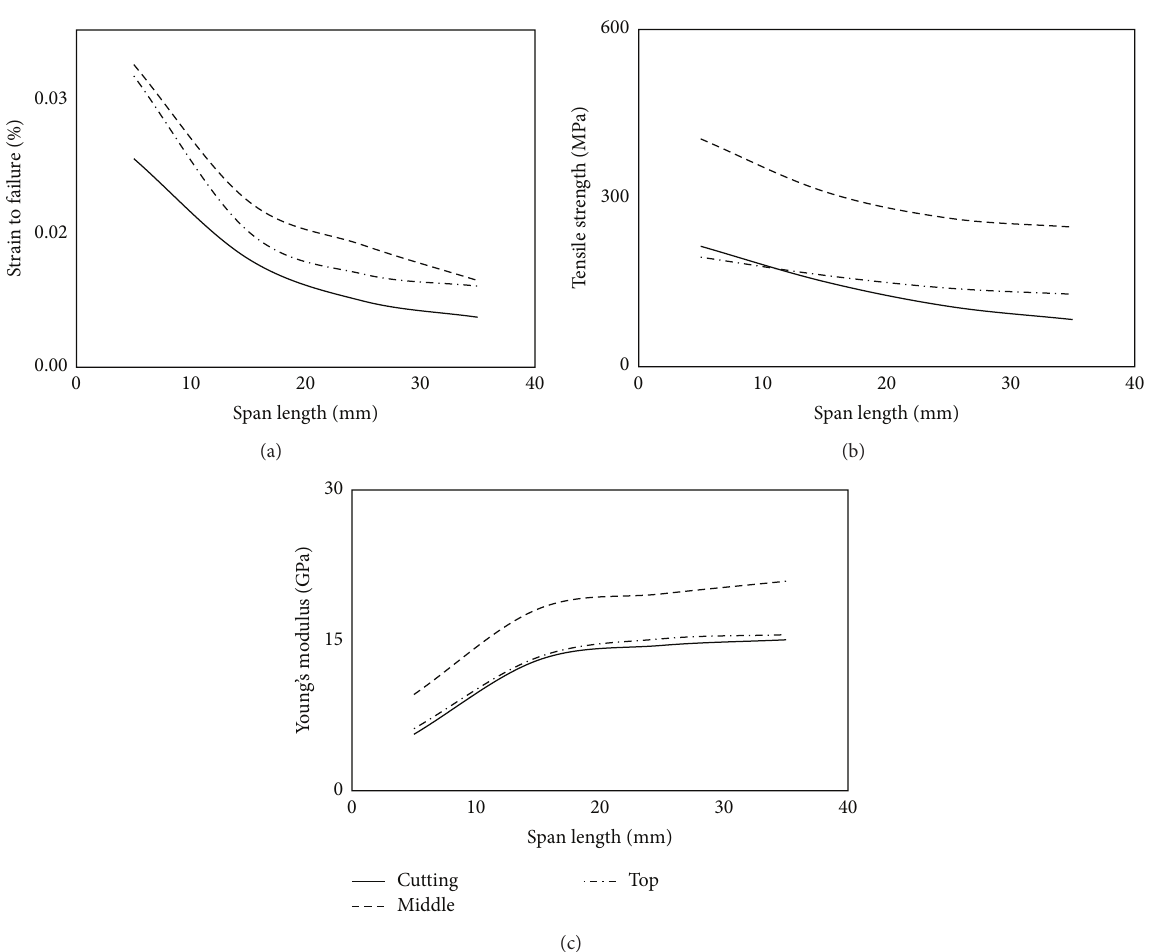
Figure 3: (a) Strain to failure, (b) tensile strength, and (c) Young’s modulus of different portions of raw jute fiber.